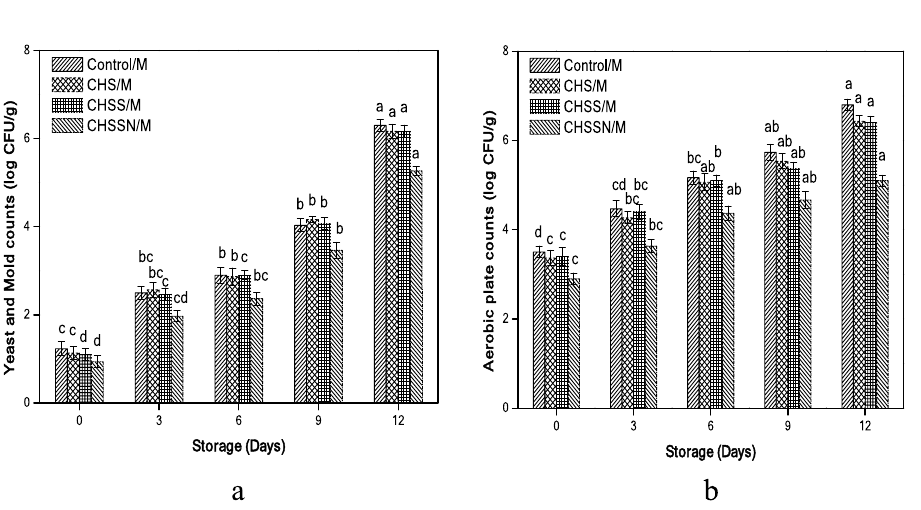
Figure 6. Effects of nano-coating treatments on microbiological populations, yeast and mold ( a ), aerobic plate counts ( b